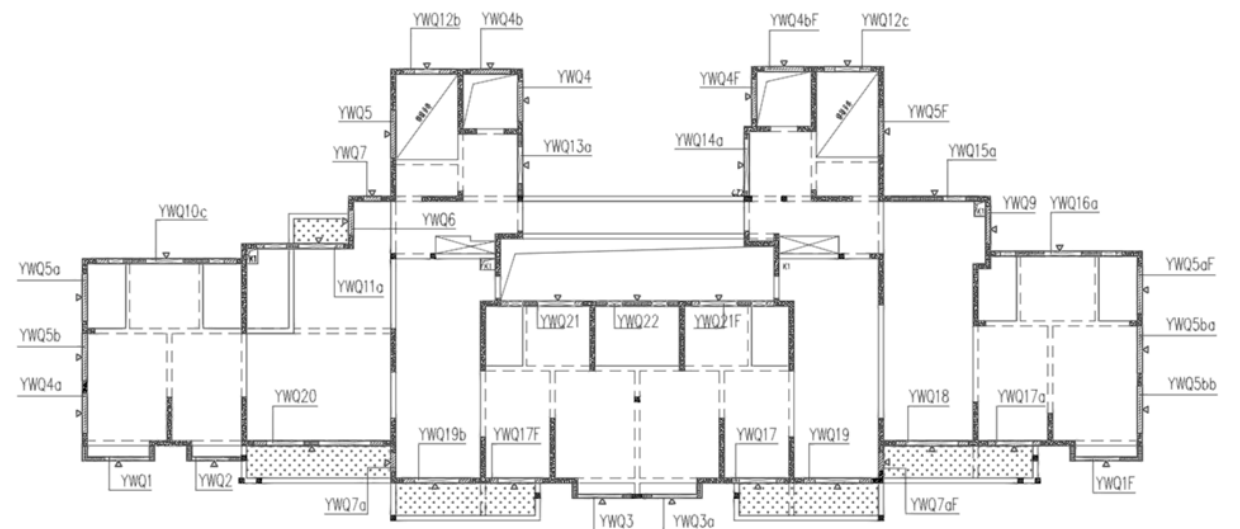
Figure 5. Plan of vertical prefabricated components of buildings #6 and #7.